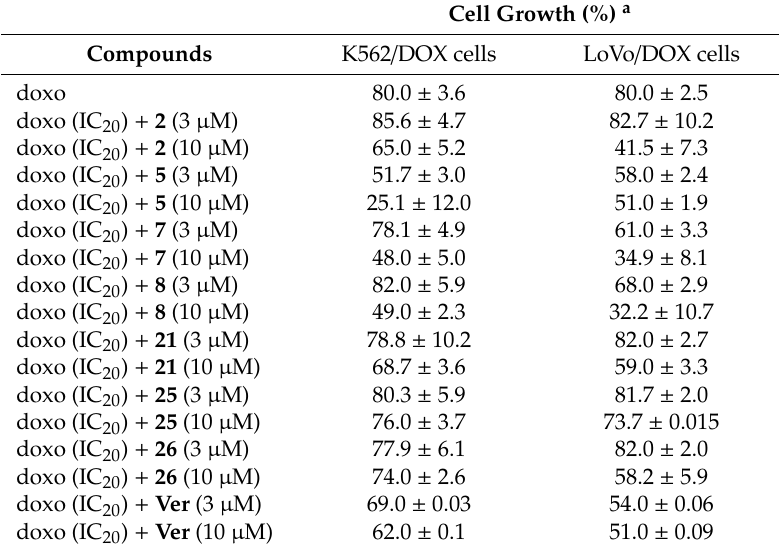
Table 2. Cells’ growth experiments performed on K562 / DOX and LoVo / DOX cells in the presence of 0.5 µ M (K562 / DOX) or 0.3 µ M (LoVo / DOX) concentrations of doxorubicin alone or in association with compounds 2 , 5 , 7 , 8 , 21 , 25 and 26 at 3 and 10 µ M